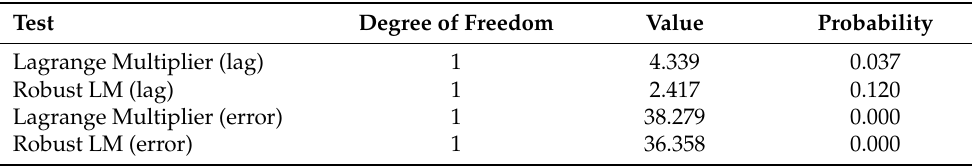
Table A2. Diagnostics for spatial dependence of urban form and carbon